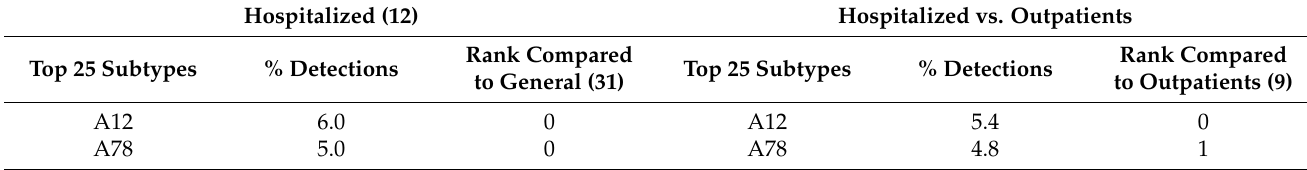
Table 2. Influence of hospitalization status on subtype rankings. Ranking of subtypes in the hospital- ized subset was compared to the general ranking (31 studies) and to the subset of studies focusing on outpatient. A positive number indicates that the subtype is ranked higher in the hospitalized subset than in the general ranking. Subtypes gaining more than 40 ranks are highlighted in green. Number of studies in each subset is indicated between